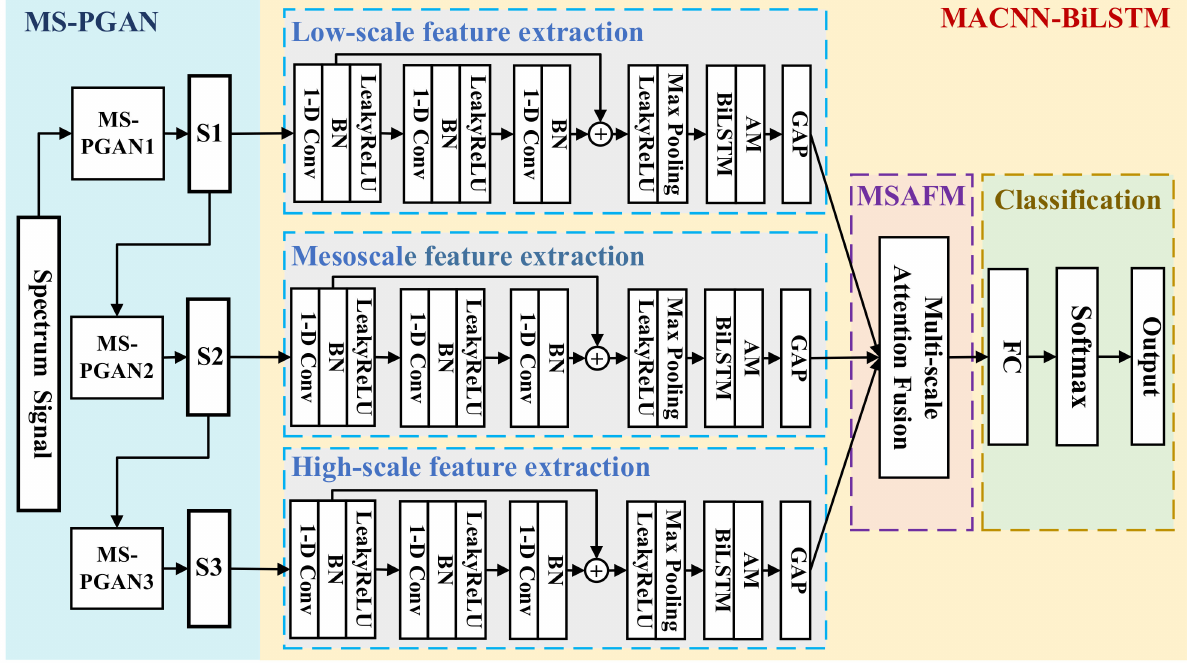
Figure 5. The network structure of MS-PGAN, combining the